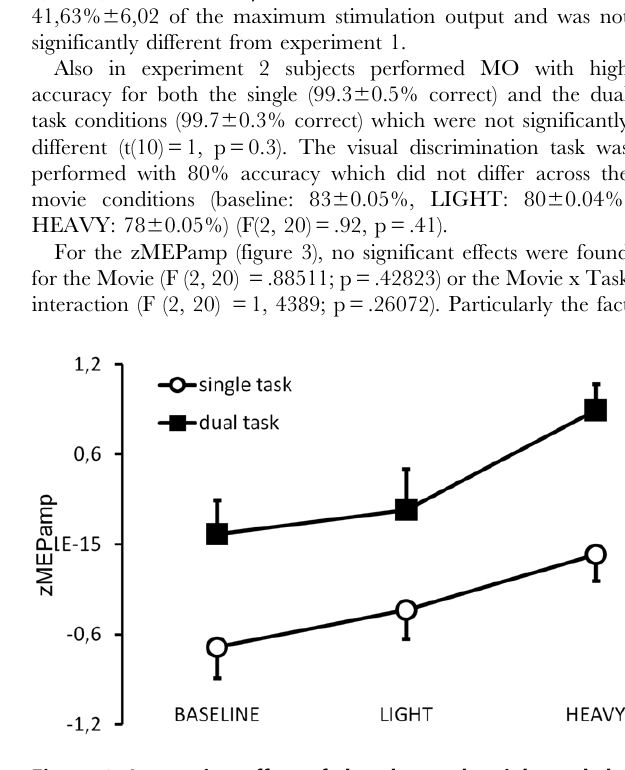
Figure 2. Interaction effect of the observed weight and the auditory discrimination task on MEP values of the OP in experiment 1. z transformed MEP amplitudes (zMEPamp) are shown for the single task (open circles) compared with the dual task (black squares) for the three different observation conditions. Vertical bars indicate standard